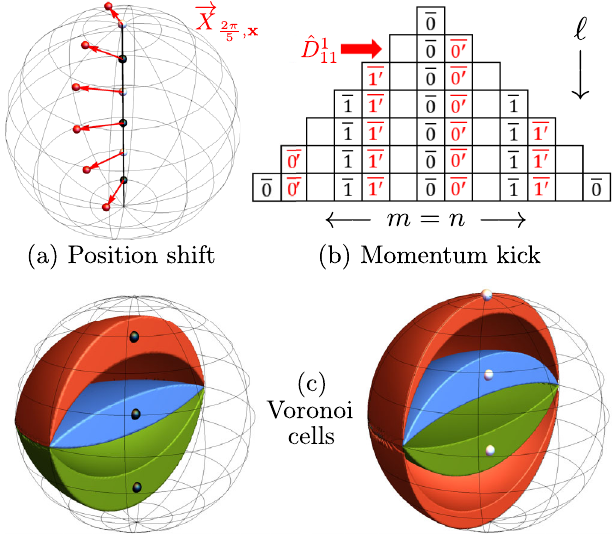
FIG. 3. Error and recovery. (a) Effect of a representative position shift on the code word group elements. The group SO 3 is represented as a 3-ball with antipodal points identified. The three group elements which are superposed in the code word ¯0 ¯1 j i ( j i ) (45) are indicated as black (white) balls. Upon the indicated representative position shift, each group element is mapped to a group element corresponding to the red ball linked by a red arrow. (b) Sketch of the j l i angular-momentum mm pyramid for 0 ≤ j m j ≤ l , where nonzero components of the ¯0 ¯1 logical- X eigenstates j and j (49) are marked in black for i i X X ˆ D 1 the case N ¼ 3 . Under the momentum kick 11 (54), these code words are mapped to error states j 0 0 i and j 1 0 i , whose X X components are marked in red. (c) Voronoi cells of group ¯0 ¯1 elements corresponding to code word j i (left) and j i (right) are indicated as a red, blue, or green